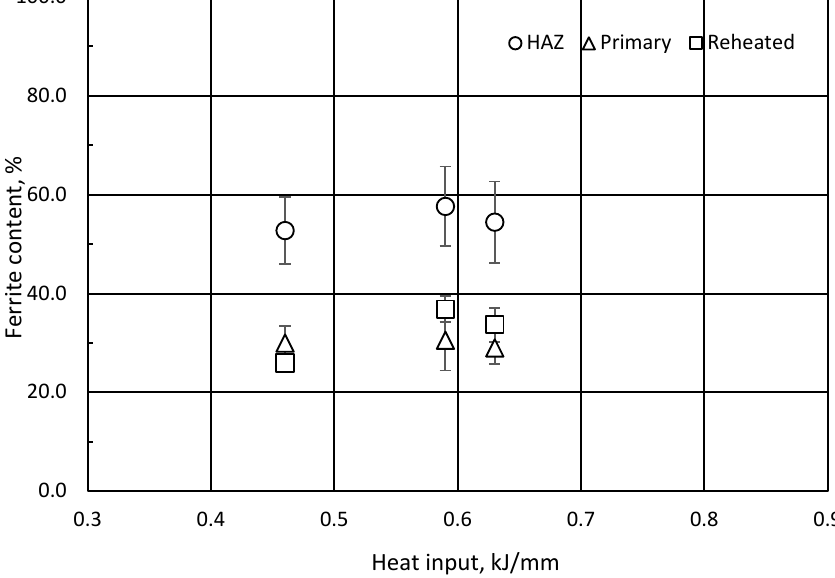
Figure 9. Ferrite content in different wall regions. Error bars indicate standard deviation.